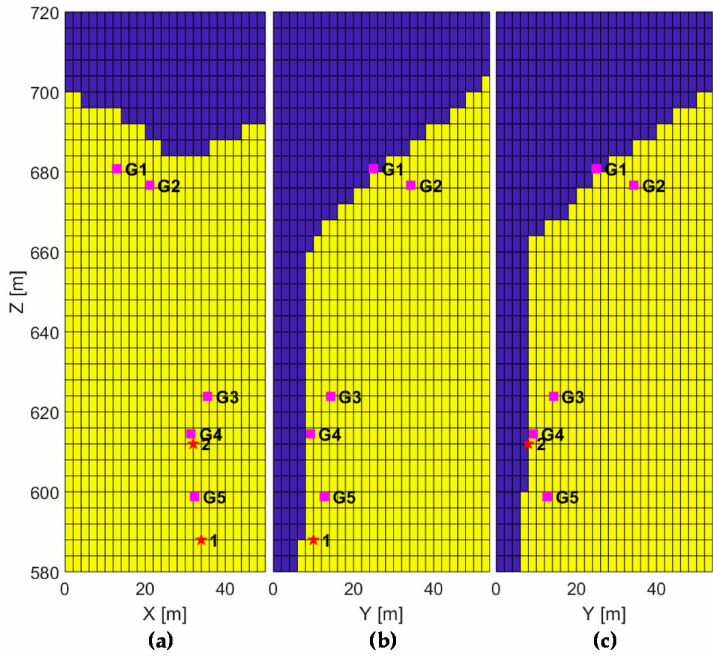
Figure 8. Location results for Rockfall event 9 (Multiple) presented on vertical slices in the front view ( a ) and side views ( b , c ). The blue area is the air, and the yellow area is the rock mass. Pink squares indicate the five 3C geophones projected on the slice. Red stars indicate the event locations projected on the slice and numbers are used to order the signals according to the arrival times.